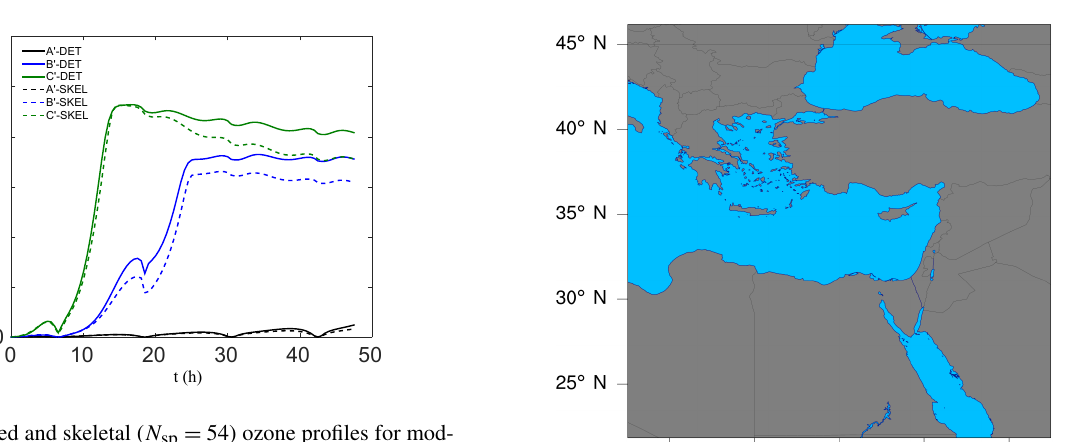
Figure 5. Detailed and skeletal ( N sp = 54) ozone profiles for mod-